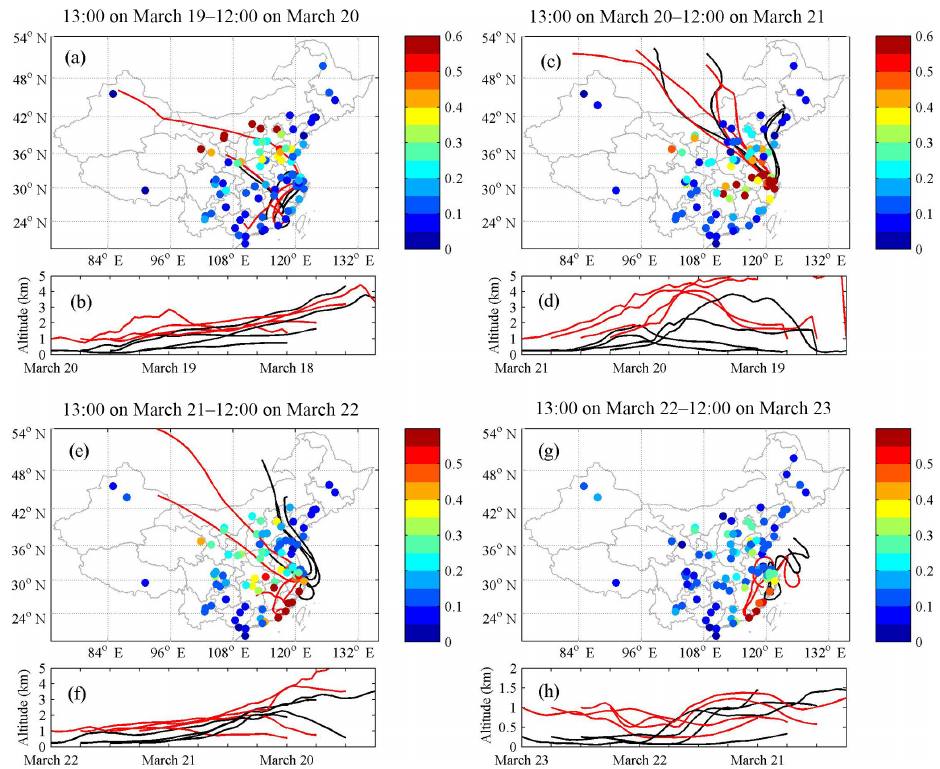
Figure 2. Daily PM 10 concentrations (mgm − 3 ) in 86 major cities over China and 48h backward trajectories of the air masses at both 250m (black lines) and 1000m (red lines) above ground level over Shanghai during 19–23 March 2010. Four trajectories ending at 00:00, 06:00, 12:00, and 18:00LST are computed for each